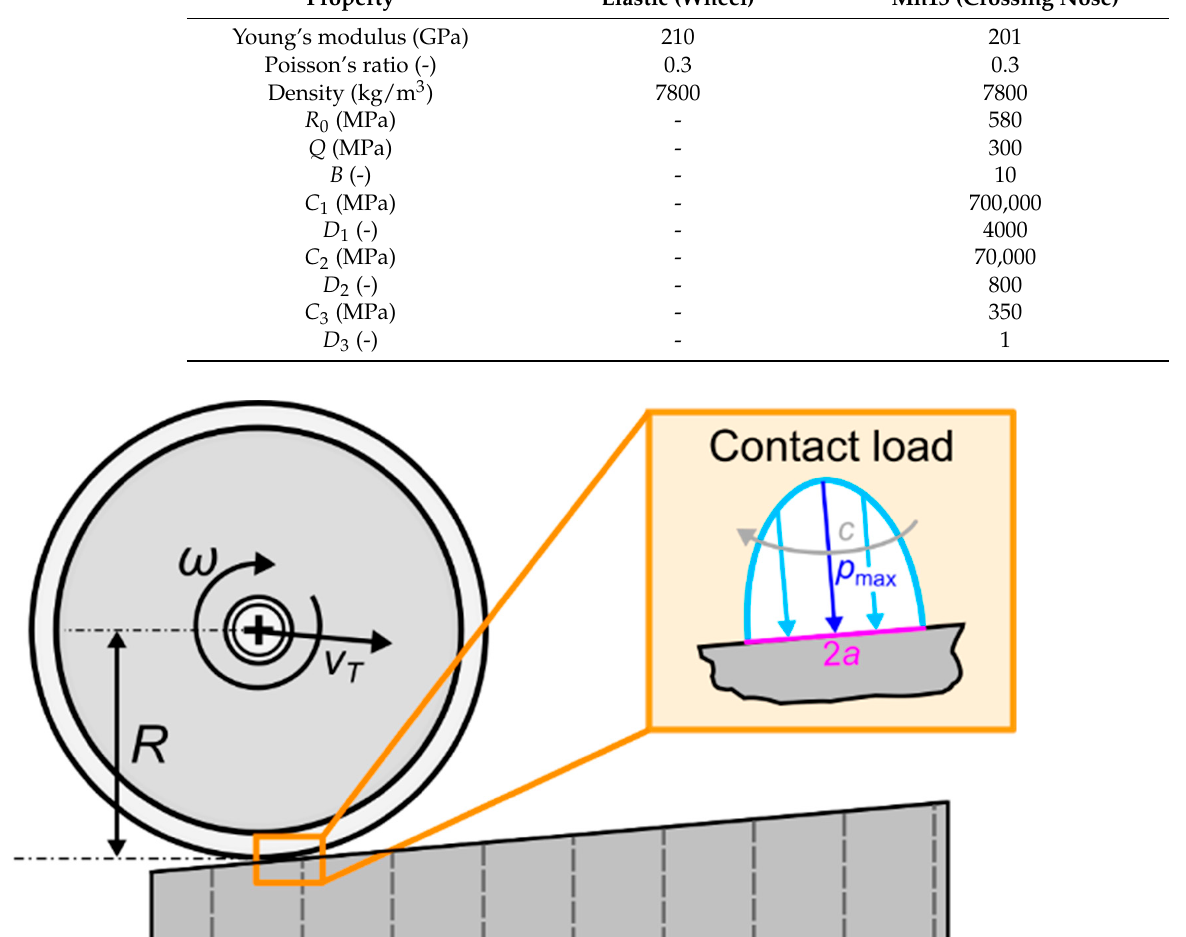
Table 2. Material properties for Mn13 in the explosion-depth-hardened and run-in state required for the wear and RCF models implemented in the simplified damage assessment tool.